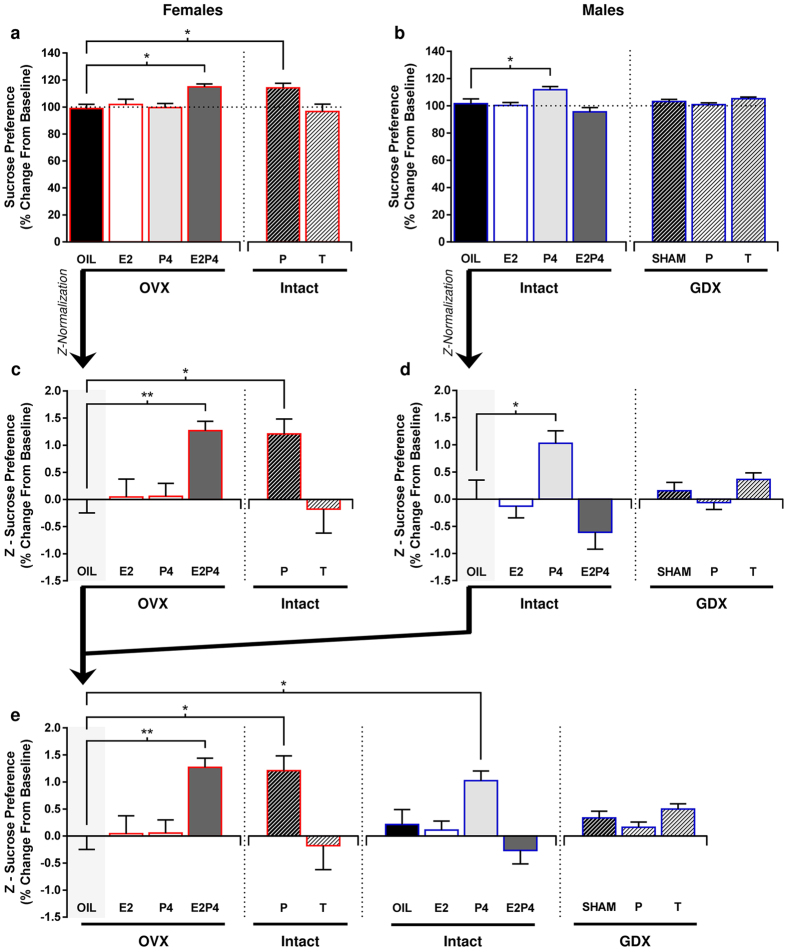
Integrated analysis of ketamine’s effects across sex and hormonal status.(a) Comparison of all groups of ovariectomized (OVX) and intact female rats demonstrating that normal cyclic fluctuation of both estradiol (E2) and progesterone (P4) levels are essential for pro-hedonic like response to low-dose ketamine (KET; 2.5 mg/kg) (*P < 0.05 vs. OVX + OIL). Data are expressed as mean ± SEM (n = 66). (b) Comparison of all groups of gonadectomized (GDX) and intact male rats reiterate the negligible effect of circulating testosterone (T) levels on male sensitivity to low-dose KET (P > 0.05), but identify effective enhancement of KET sensitivity in intact male rats by P4 treatment (*P < 0.05 vs. Intact + OIL). Data in (a,b) are presented as the percent change in sucrose preference following KET administration relative to saline (SAL) baseline levels, averaged across all days of the post-treatment period. Data are expressed as mean ± SEM (n = 68). (c,d) Standardization of female (n = 66) and male (n = 68) sucrose preference scores presented in (a,b), respectively, via Z-score transformation relative to OIL-treated groups of each sex (**P < 0.01, *P < 0.05). Data are expressed as mean ± SEM. (e) Percent change in sucrose preference levels from baseline following KET administration compared across sex and all hormone treatments via Z-score normalization of each group’s scores to OVX + OIL female rats. The magnitude of pro-hedonic like effects of KET was found to be similar in OVX + E2P4 (**P < 0.01) and Intact + P (*P < 0.05) female and P4-treated intact males (*P < 0.05) when controlling for unequal variances between all experimental cohorts. Data are expressed as mean ± SEM (n = 134).